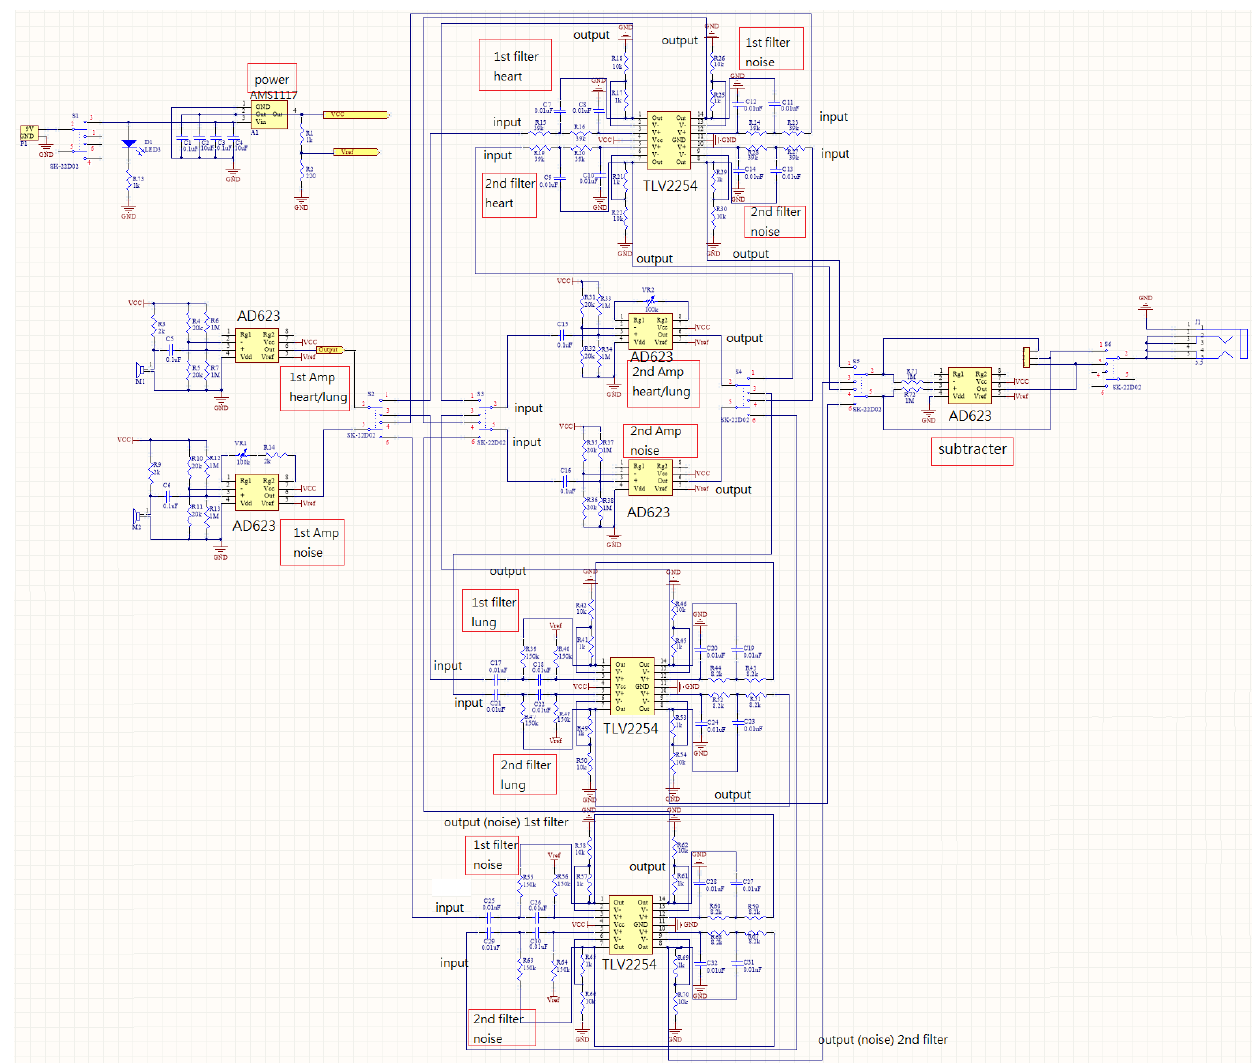
Figure 5. ( a ) Filter circuit for heart sounds and ( b ) filter circuit for lung sounds.